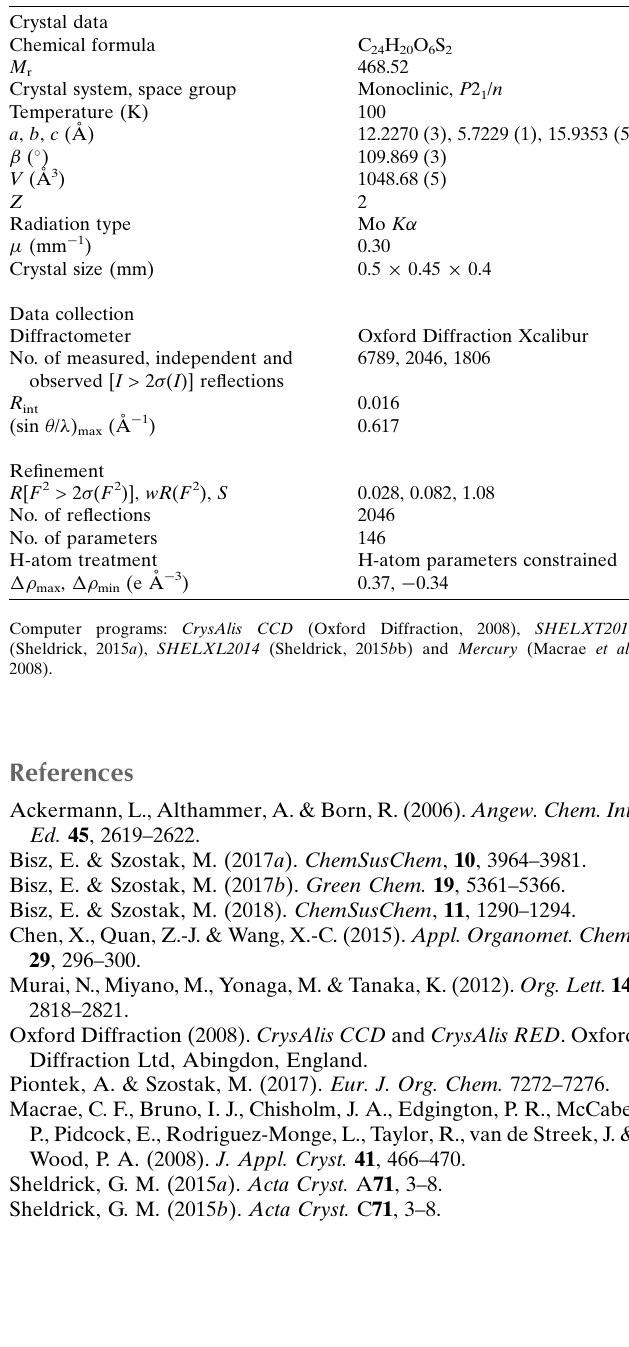
Table 2 Experimental details.